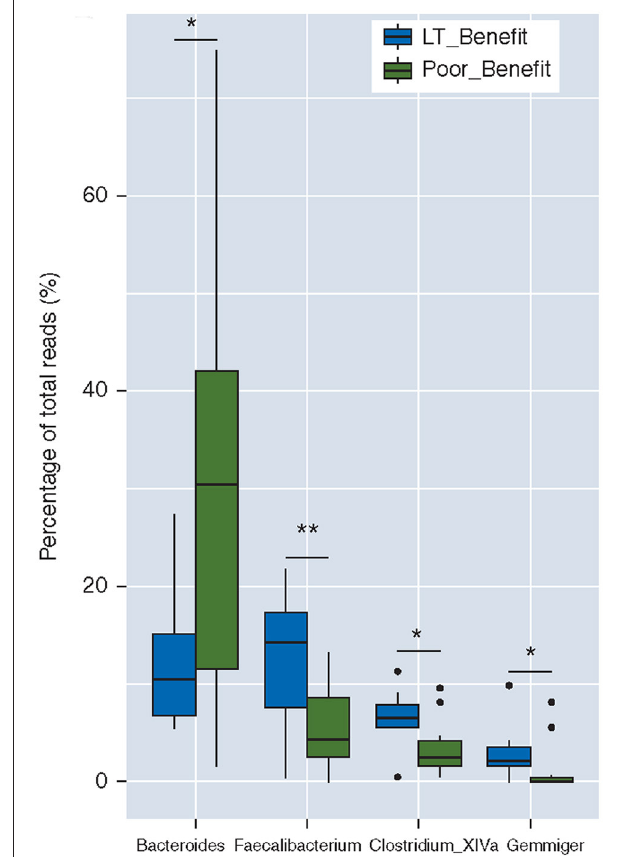
FIGURE 3 | Baseline gut microbiota as a predictor of response to ipilimumab. Boxplot of the percentages of four dominant ( > 1% of total reads) genera differentially represented between both groups, i.e., Bacteroides, Faecalibacterium, Clostridium XIVa , and Gemmiger ; LT_Benefit, long-term benefit vs. Poor Benefit; * P < 0.05; ** P < 0.001 [The figure is reprinted with permission from Chaput et al.